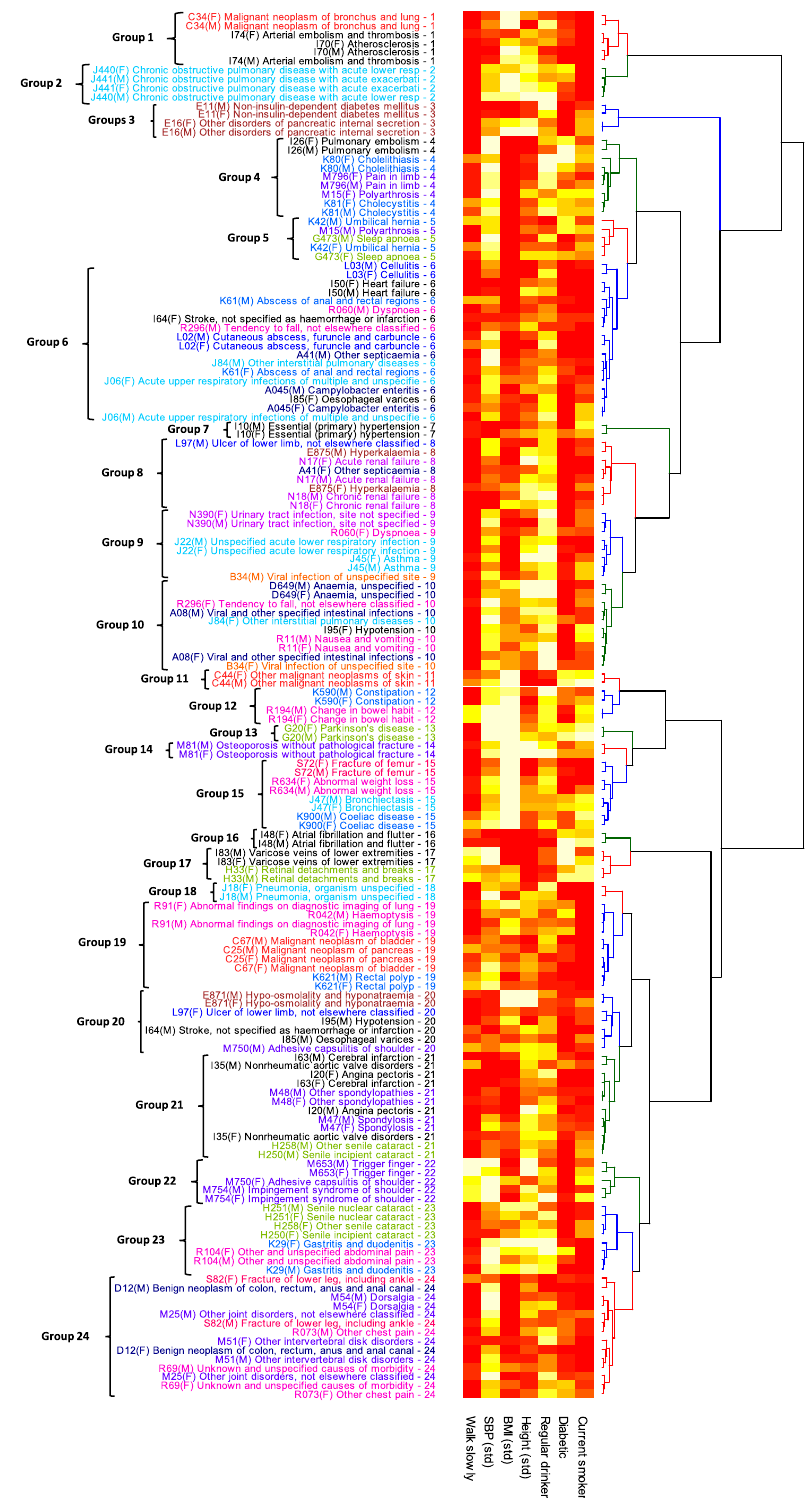
Figure 5. The estimated fitting parameters and their covariance matrices were used to calculate the Bhattacharyya distances between diseases, and clustered hierarchically using the Ward.D2 algorithm. Diseases in men and women tend to cluster adjacently. Labels are coloured by their first ICD-10 digit, and the dendrogram is coloured with the top 24 groups in the cluster (see Fig. 1). Associations with potential risk factors are indicated by the heat map, with red an association with higher risk, white with lower risk, and orange neutral. The figure was produced with R 34 using packages “dendextend” 40 and “gplots” 41